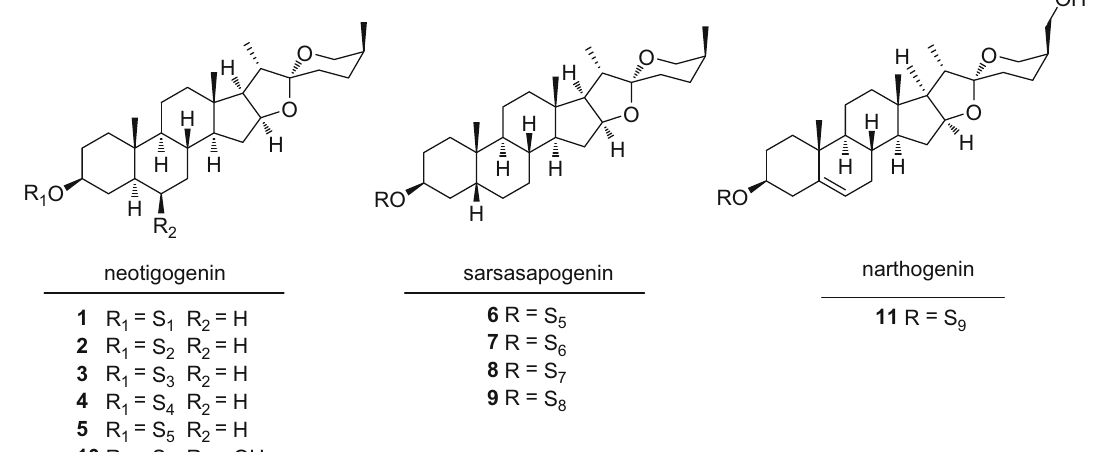
Fig. 2 Structures of compounds 1 –